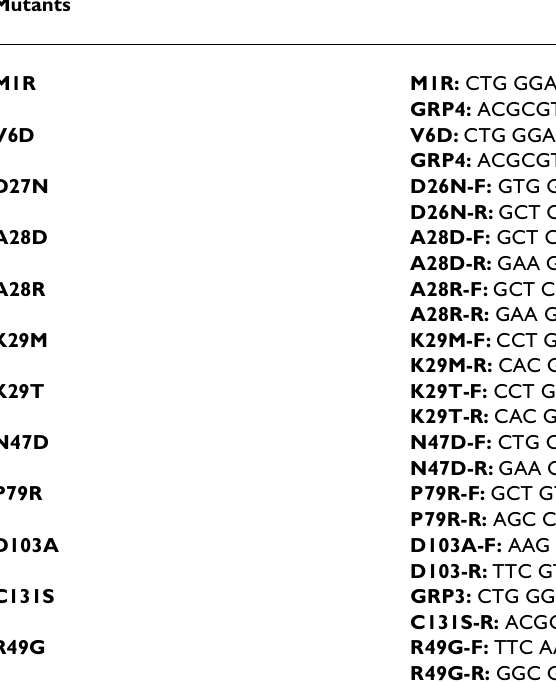
Table 2: Oligonucleotide Primers used for Overlap Extension Mutants